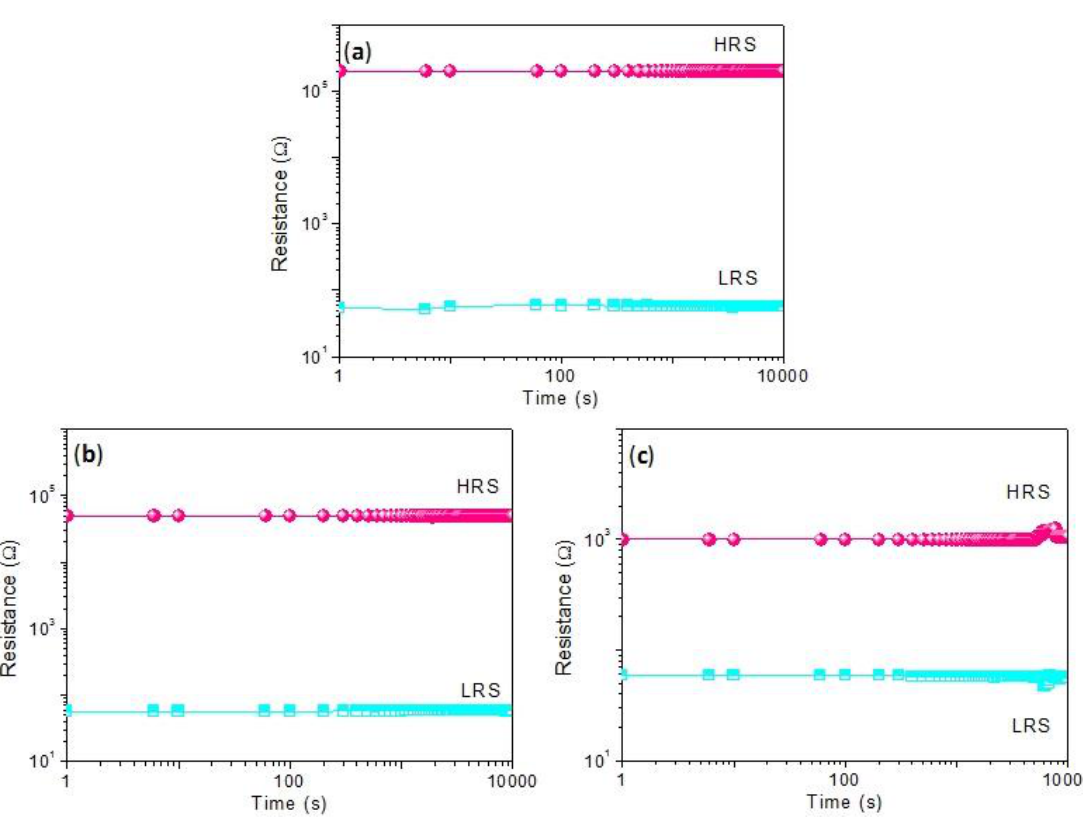
Figure7. Retentiontestataconstantvoltageof − 0.1Vfor( a )Ni / CCS:1wt%GQDs / ITO,( b )Ni / CCS:3wt% Figure 7. Retention test at a constant voltage of −0.1 V for ( a ) Ni/CCS:1 wt% GQDs/ITO, ( b ) GQDs / ITO and ( c ) Ni / CCS:5 wt% GQDs / Ni/CCS:3 wt% GQDs/ITO and ( c ) Ni/CCS:5 wt% GQDs/ITO.